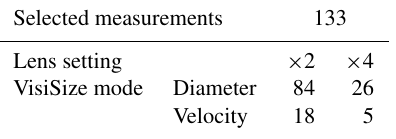
Table 2. Statistics of the VisiSize measurements at the UFS dur- ing the 2019 campaign listing the number of selected measurement cases for different modes and lens magnification